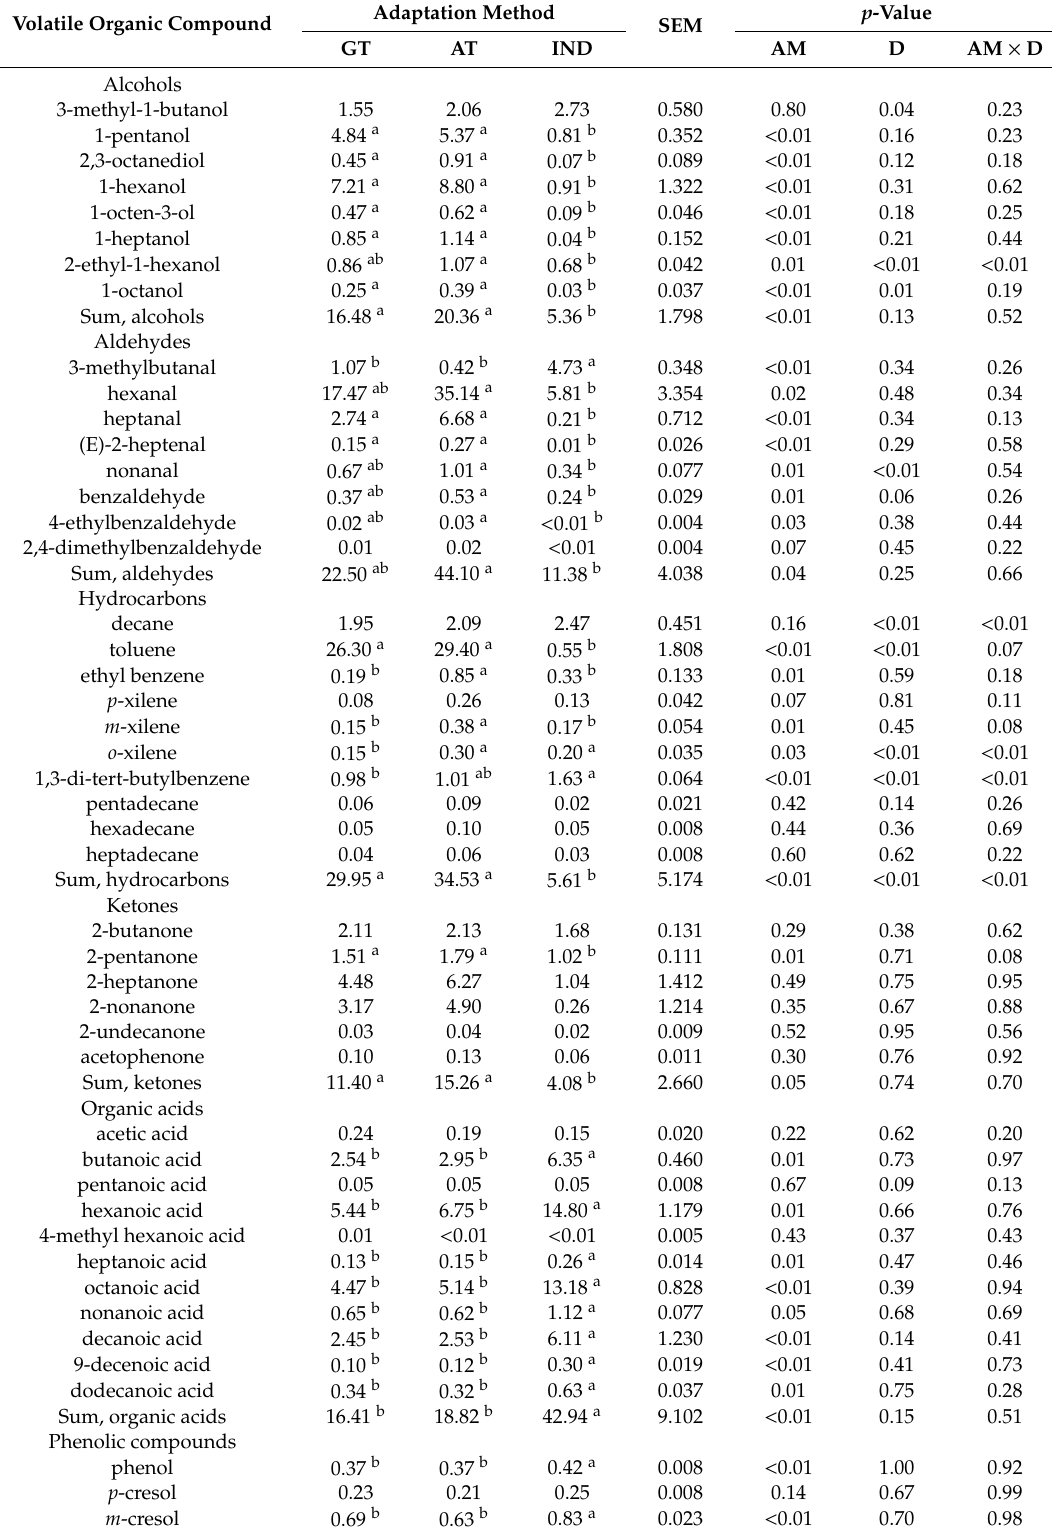
Table 2. Mean values of volatiles organic compounds ( µ g / kg equivalent of 4-methyl-2-pentanone [36]) in milk ( n =